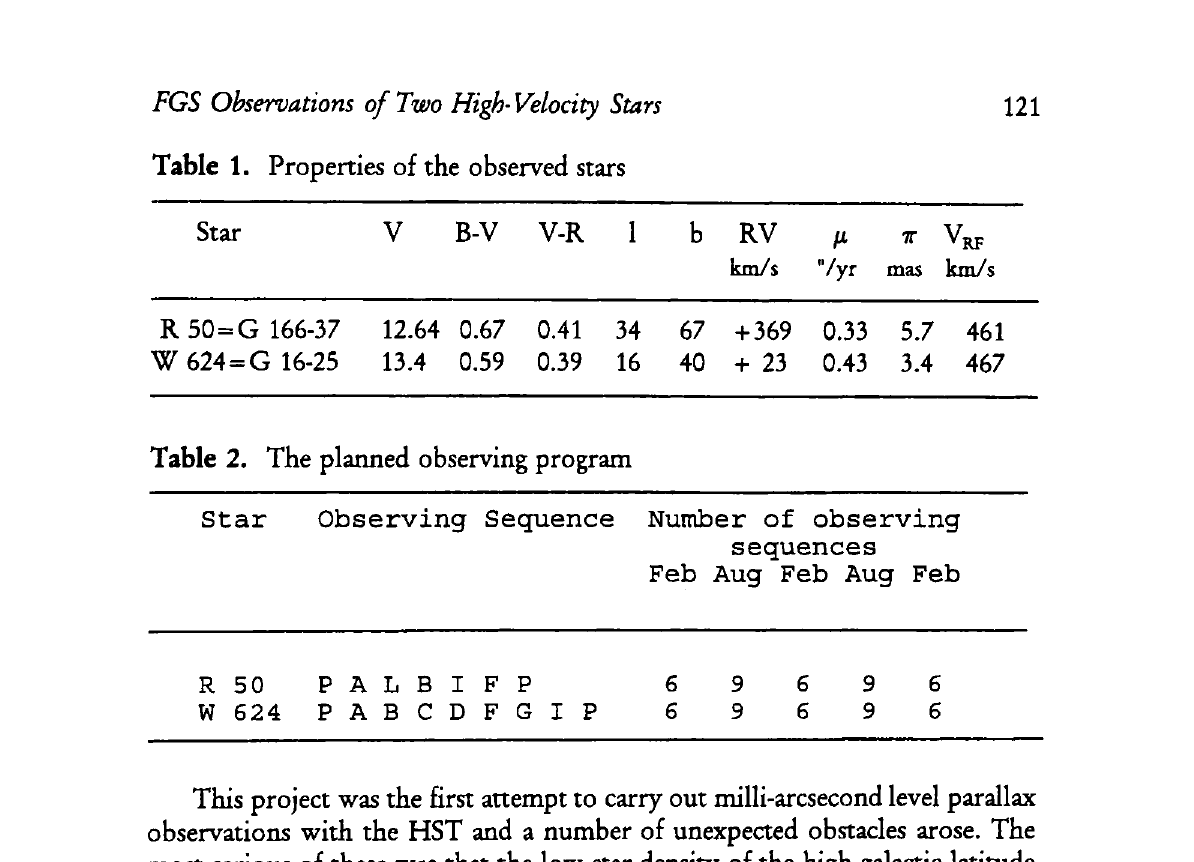
sequences Feb Aug Feb Aug